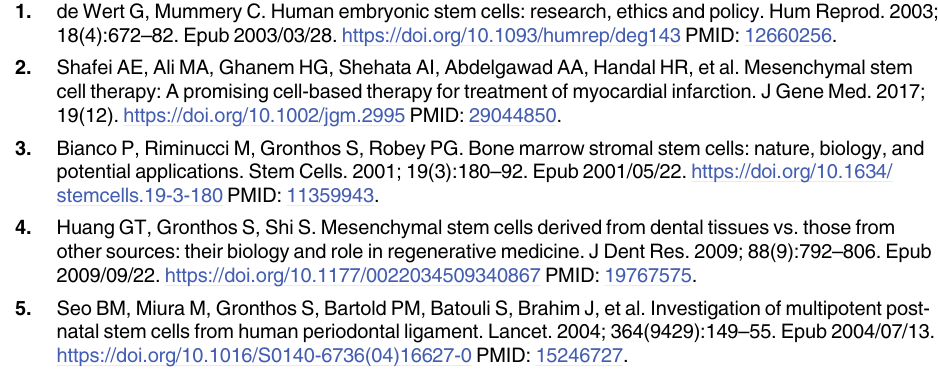
S1 Table. Constitution of the reaction mixtures. Preparation of poly(succinimide) gels with different cross-linkers and cross-linking ratio. S2 Table. Constitution of the reaction mixtures. Preparation of poly(succinimide) gels with different thiol contents. S1 Fig. Schematic figure of the hydrogel synthesis with different thiol content. S2 Fig. Calibration for thiol groups measurements. S3 Fig. Phase-contrast microscopic pictures of PDL stem cells on PASP hydrogel disks with different cross-linking agents (DAB or CYS) and crosslinking degree 20 or 40. Each photomicrograph was taken at the same magnification. The scale bar indicates 100 μ